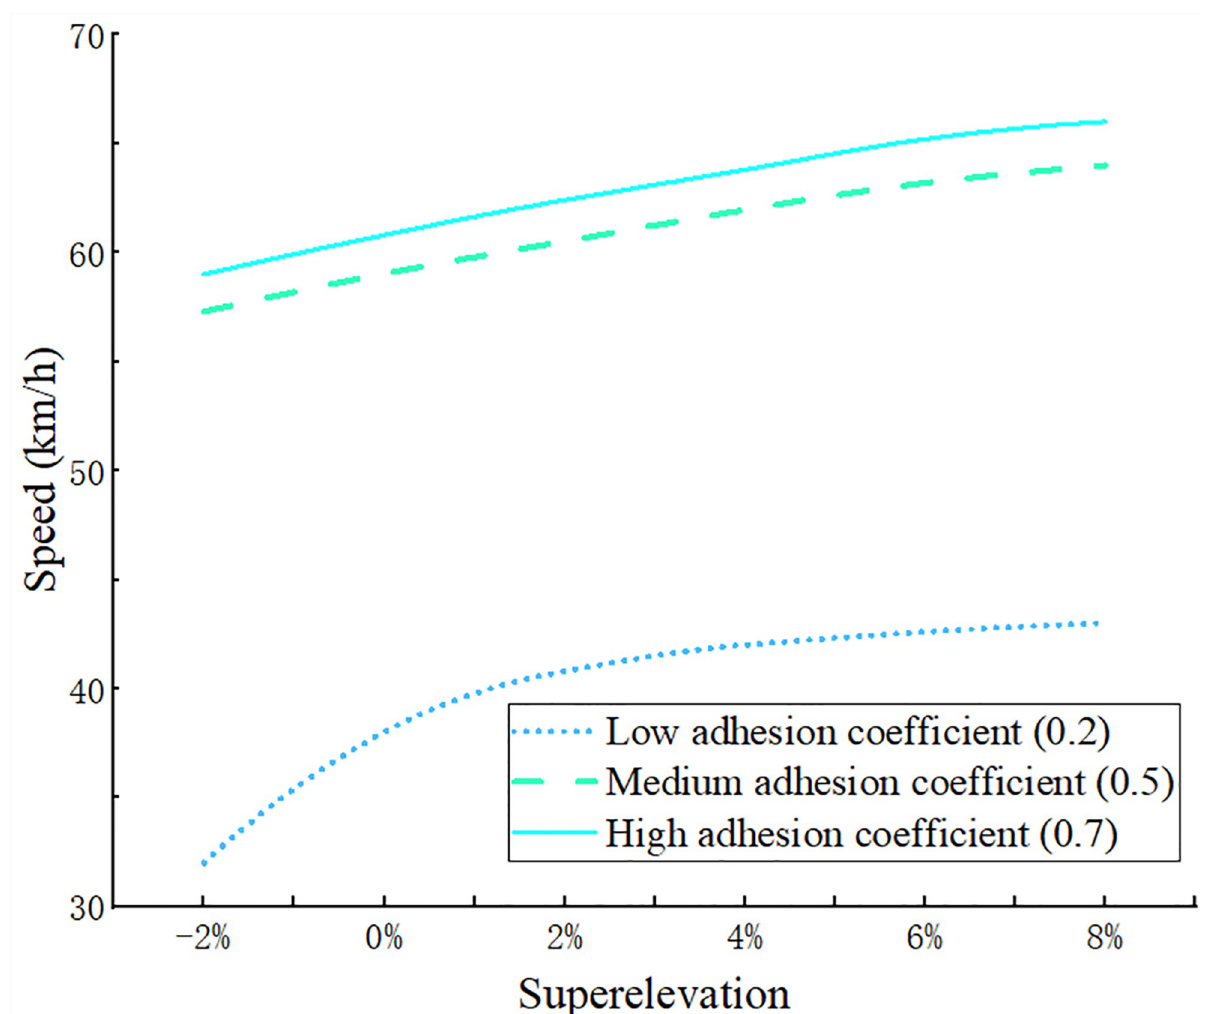
Fig 14. The curve of the instability speed threshold of truck driving corresponding to different road